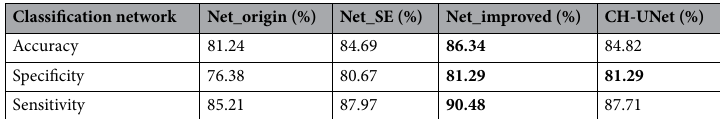
classification performance. In Table 6, Net_origin refers to the classification performance of a dual-branch classification network without the above three improvements (attention mechanism, cross-hierarchical feature fusion, nodular aspect ratio fusion). Net_SE refers to the traditional attention mechanism based on the fusion of the cross-level feature and nodular aspect ratio. Net_improved refers to the two-channel classification network with the GSAM, cross- level feature fusion, and nodular aspect ratio fusion proposed in this paper. CH-UNet 28 refers to Classification Head-UNet, the champion model of the Thyroid Nodule Classification Competition TN-SCUI 2020, which was evaluated on the dataset of this paper. As presented in Table 6, the accuracy, specificity, and sensitivity of the